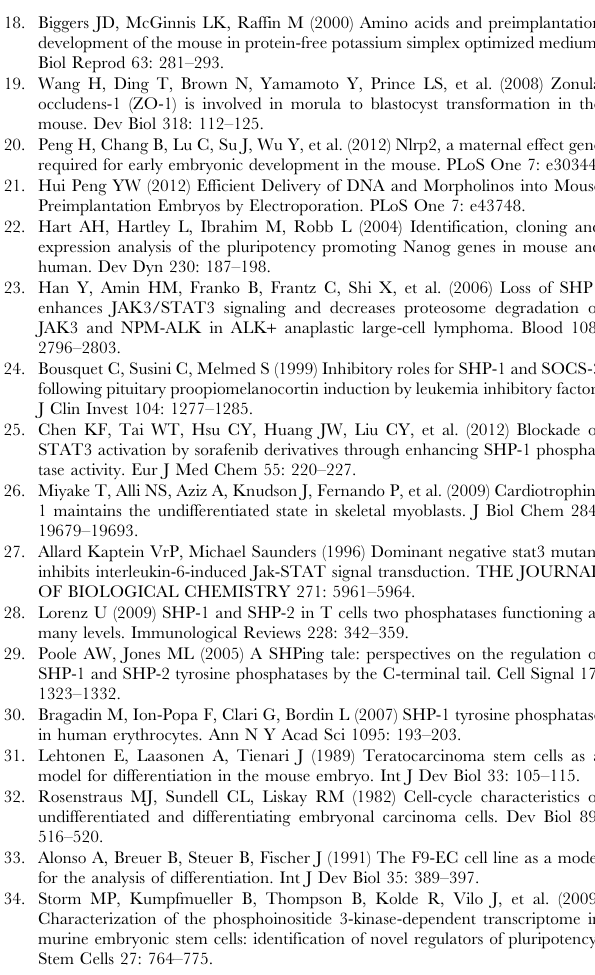
Table S2 Sequences of primers for Real-Time PCR.